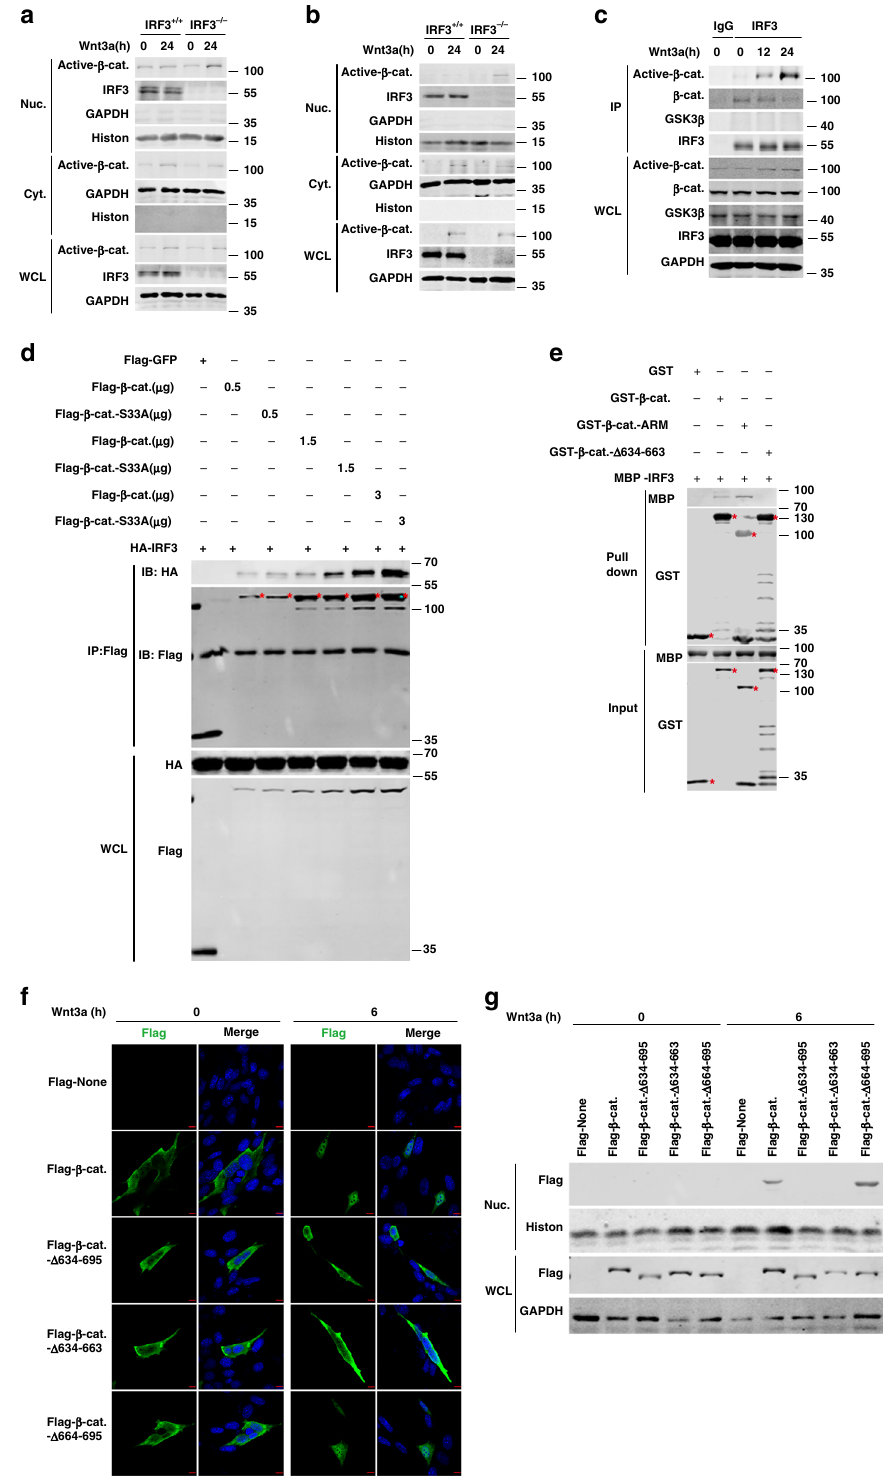
Fig. 5 IRF3 binds the ARM domain of β -catenin and prevents its nucleus translocation. a , b Nucleocytoplasmic separation and immunoblot analysis of Active- β -catenin in HCT116 ( a ) and H1299 ( b ) cells after treated with wnt3a-conditioned medium. c Immunoblot analysis of the endogenous interaction between active- β -catenin, β -catenin, or GSK3 β and IRF3 with anti-IRF3 immunoprecipitates in HCT116 cell line extracts after treated with wnt3a- conditioned medium. d Immunoblot analysis of the interaction between β -catenin or β -catenin-S33A and IRF3 with anti-FLAG immunoprecipitates in HEK293T cell line. e Pull-down analysis the interaction between GST- β -catenin, GST- β -catenin-ARM, or GST- β -catenin- Δ 634-663 and MBP-IRF3. f , g Immuno fl uorescence ( f ) and nucleocytoplasmic separation ( g ) analysis for the cellular localization of β -catenin or its mutants in HEK293 cell line upon wnt3a-conditioned medium treatment. Red scale bars, 10 μ m. Data represent three independent experiments ( a – g ). Source data are provided as a Source data fi le. See also Supplementary Fig.